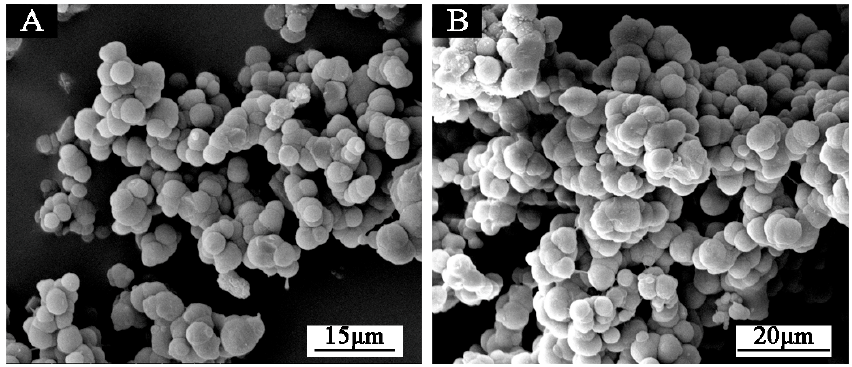
Figure 1. Scanning electron microscope (SEM) of microcapsules: ( A ) large magnification; ( B ) small magnification.